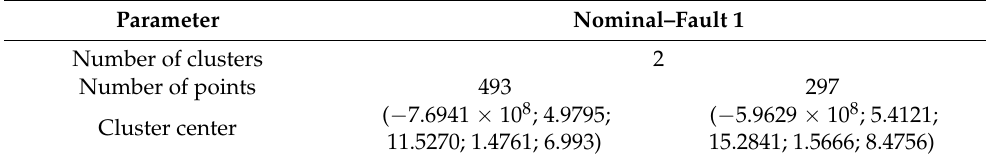
Table 8. Cluster local parameter obtained from the pretraining phase (sealing group).